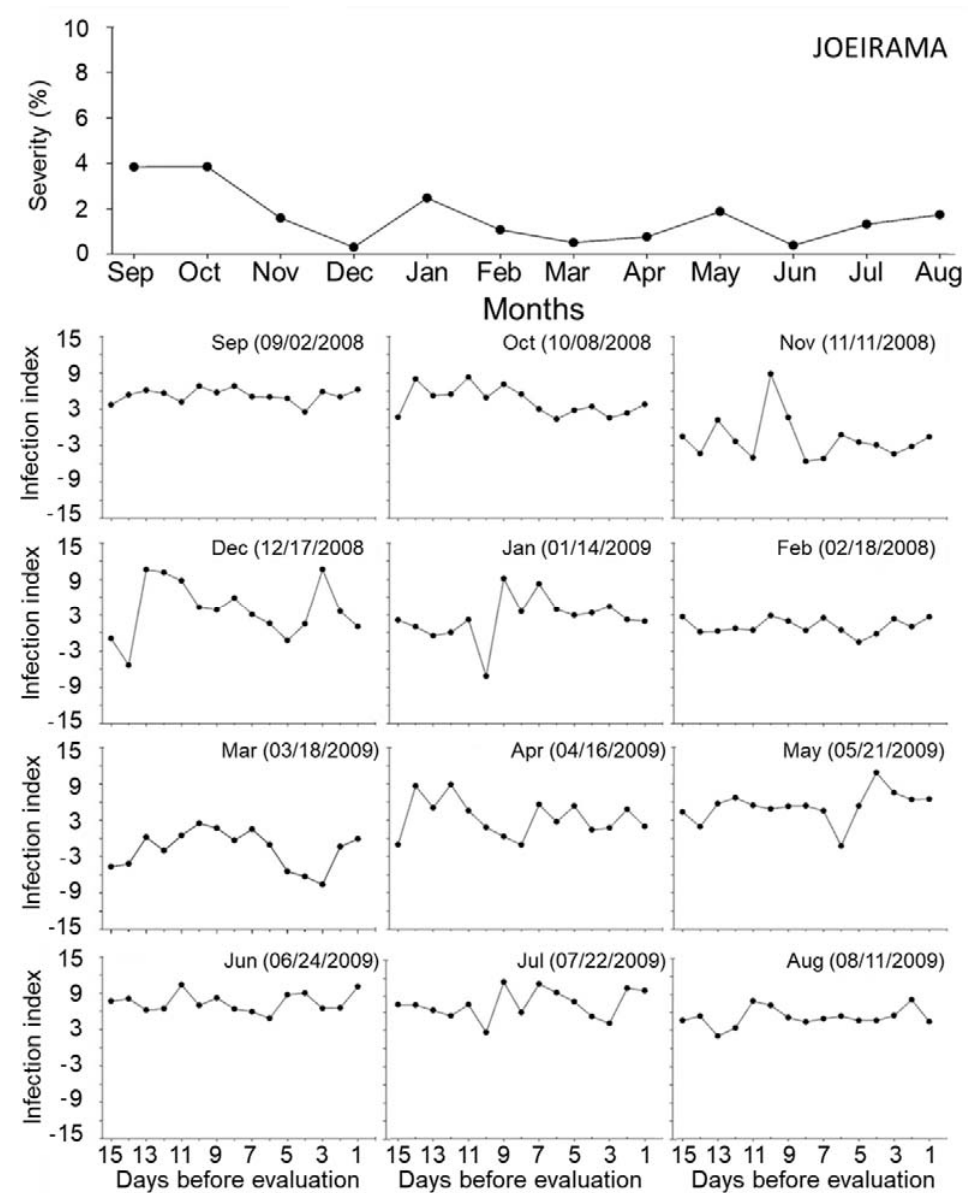
Figure 8. The severity of eucalyptus rust (%) and infection index were evaluated under field conditions and used to calculate the infection index according to the equation of [11], for the 15-day period prior to the monthly evaluations conducted in September 2008 through August 2009, in the municipality of Joeirana, located in the extreme south of Bahia, Brazil.